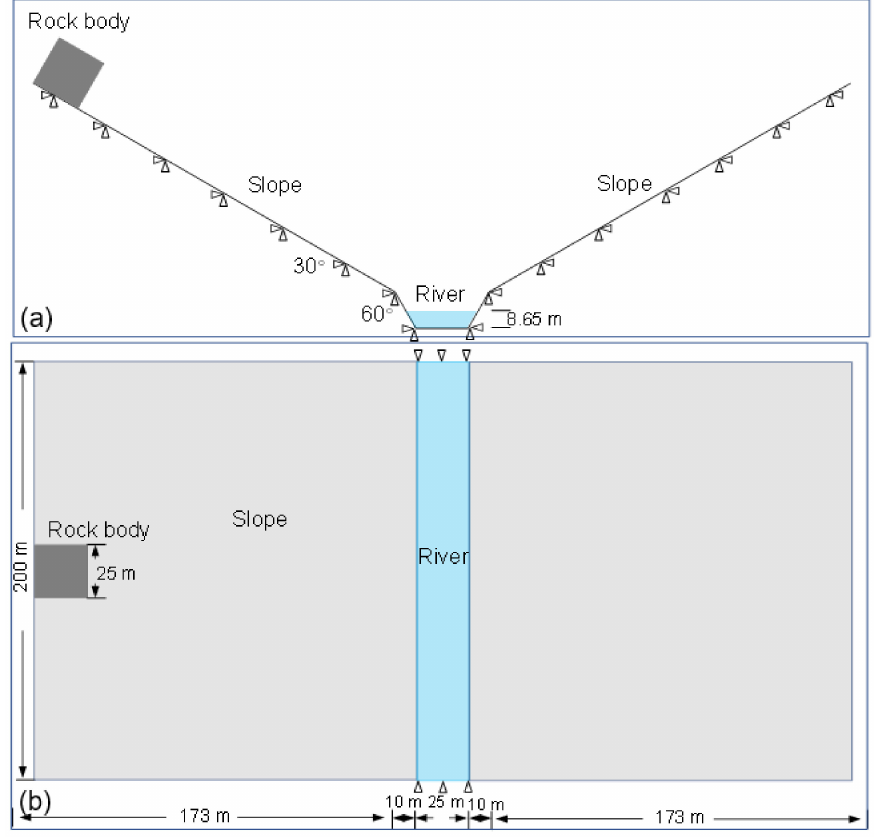
Figure 6. Geometry of the landslide river-blocking model: ( a ) longitudinal profile view; ( b ) plane